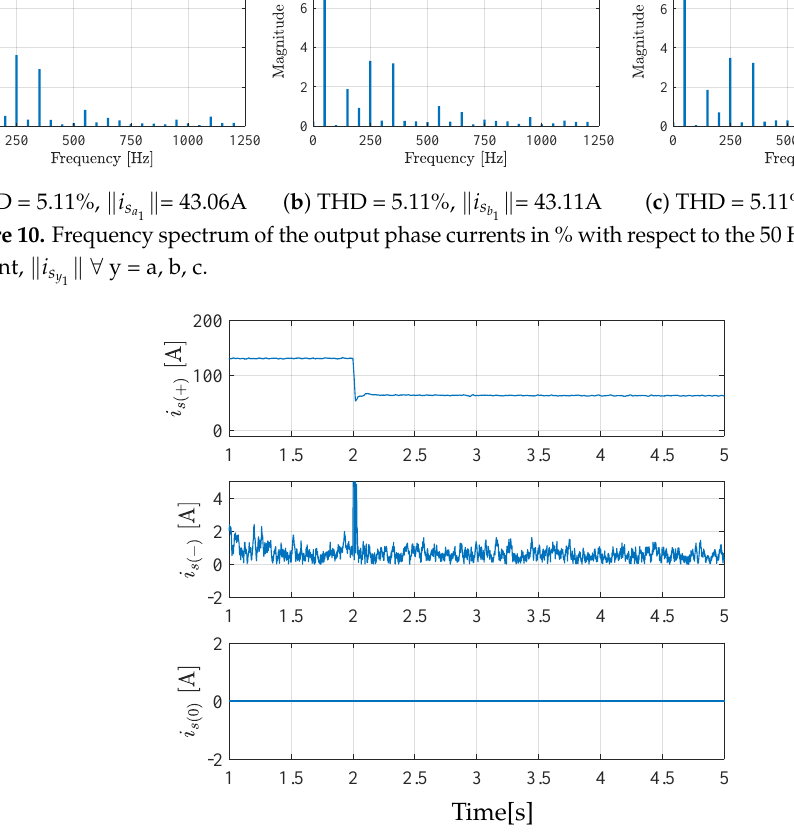
Figure 11. The positive sequence current ( i s (+) ), negative sequence current ( i s ( current ( i s ( 0 ) ) for the currents injected to the grid for scenario